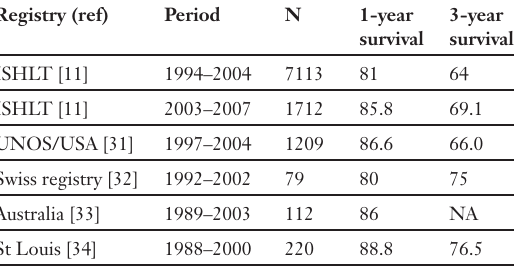
ISHLT = International Society for Heart and Lung Transplantation UNOS = United Network for Organ Sharing